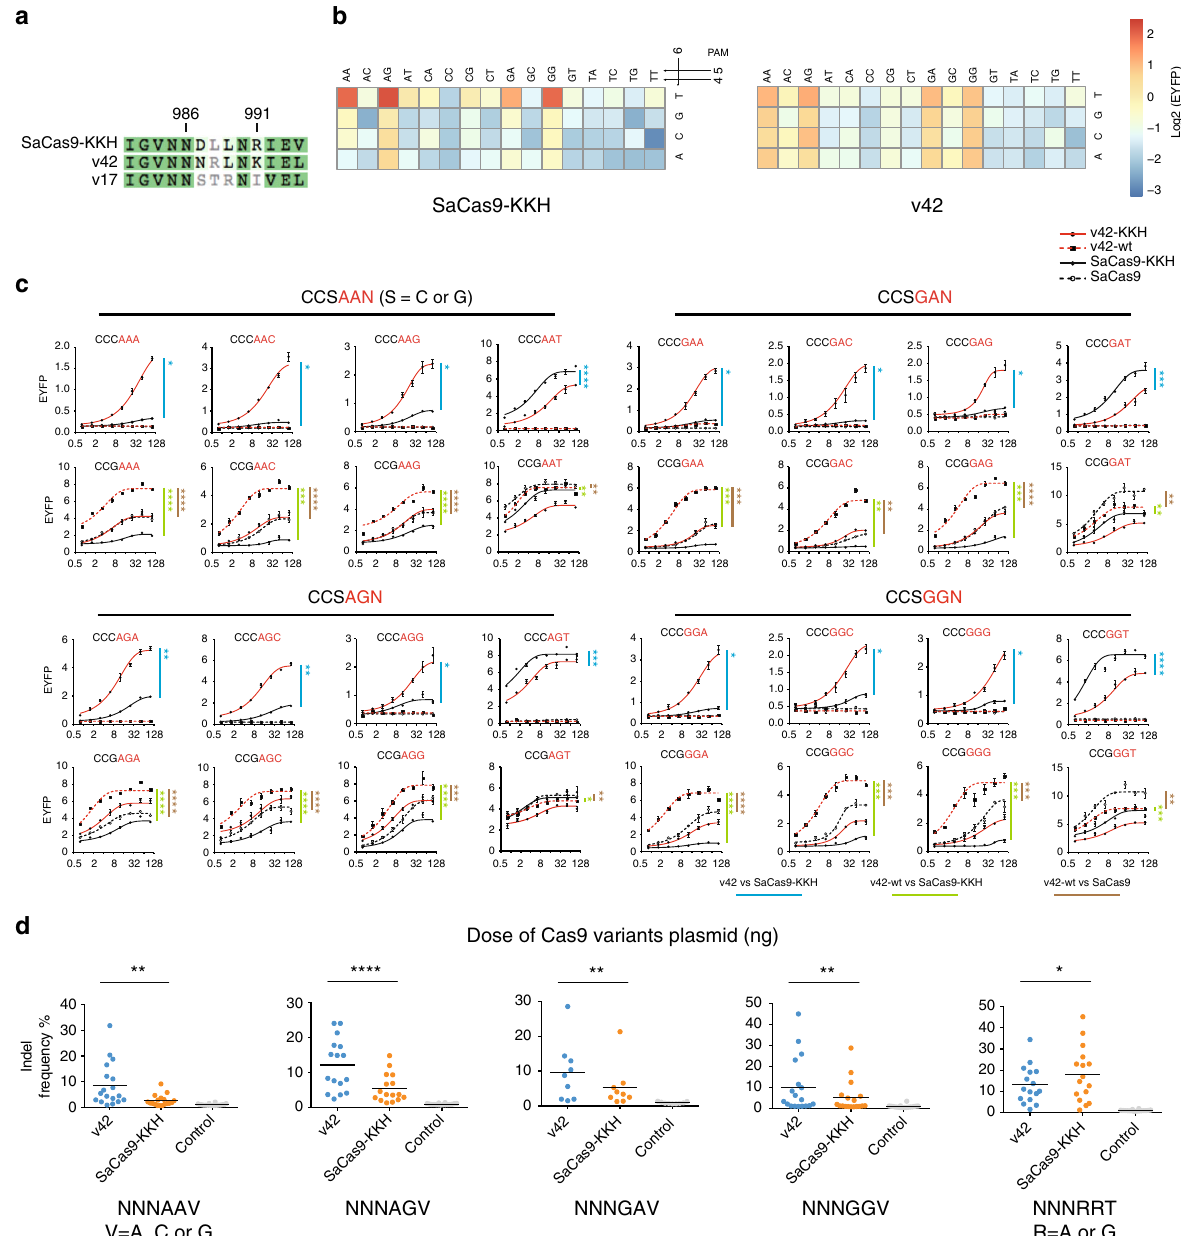
Fig. 2 Characterization of PAM recognition of cCas9 v42. a Sequence alignment of the key 13-aa region of the PI domain in SaCas9-KKH, cCas9 v42, and v17. b Functional characterization of SaCas9-KKH and cCas9 v42 at CCCNNN PAMs. Schematic of the EYFP reconstitution assay is shown in Fig. 1c. Data indicated the mean of three independent biological replicates. c Functional comparison of v42-KKH, v42-wild-type (v42-wt), SaCas9 and SaCas9-KKH at CCGRRN and CCCRRN across eight plasmid doses by using the EYFP reconstitution assay. Data indicated the mean ± s.e.m. ( n = 3 independent biological replicates). The relative EYFP fl uorescence intensity ( y -axis) was measured by FACS. d Indel frequencies induced by v42 or SaCas9-KKH at sites with NNNRRN PAMs measured by next-generation sequencing. Each point represents the mean of one endogenous site ( n = 3 independent biological replicates). The black line indicates the mean of all targets. c and d * P < 0.05 (paired t -test, two-tailed); ** P < 0.01 (paired t -test, two-tailed); *** P < 0.001 (paired t -test, two-tailed); **** P < 0.0001 (paired t -test, two-tailed). Source data are provided as a Source Data fi